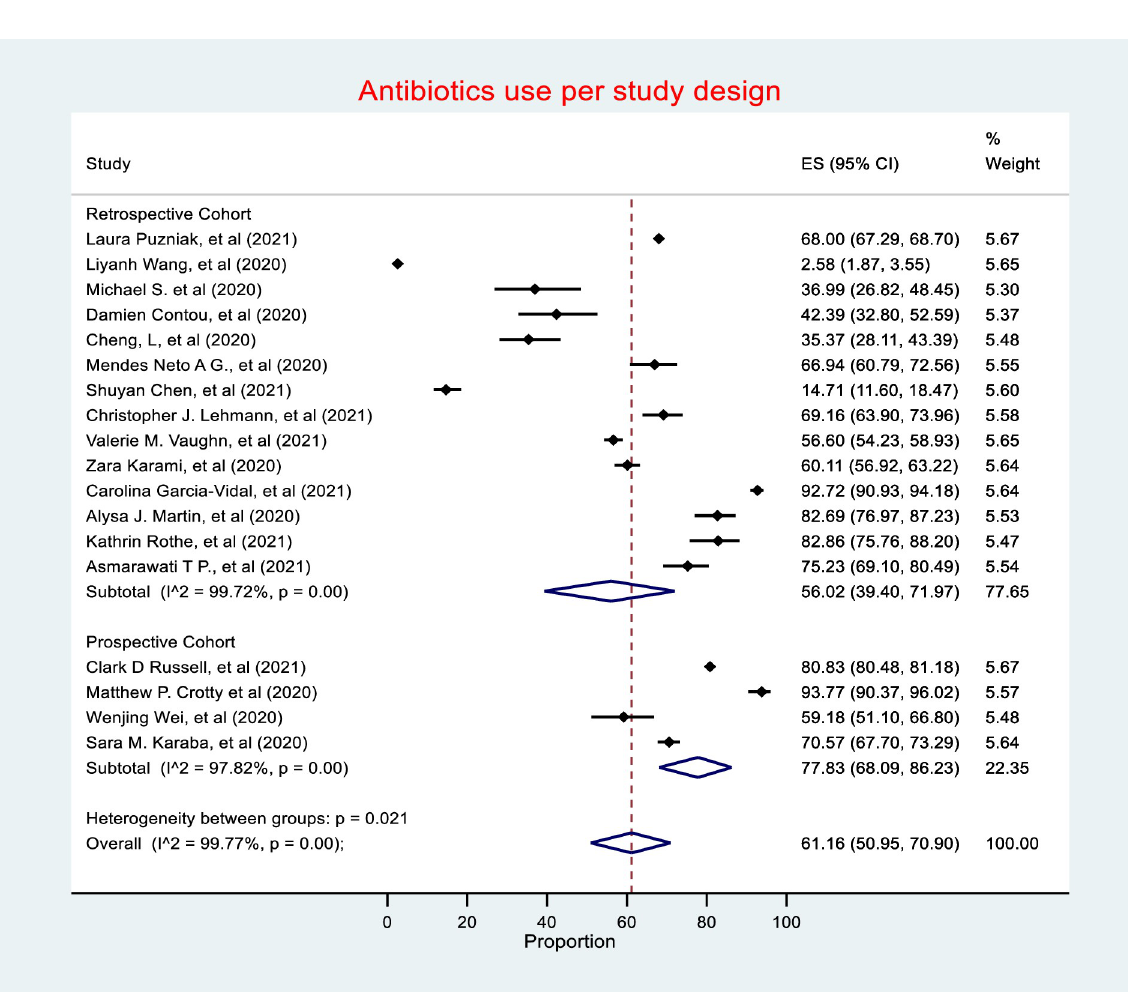
Fig 7. Antibiotic use by study